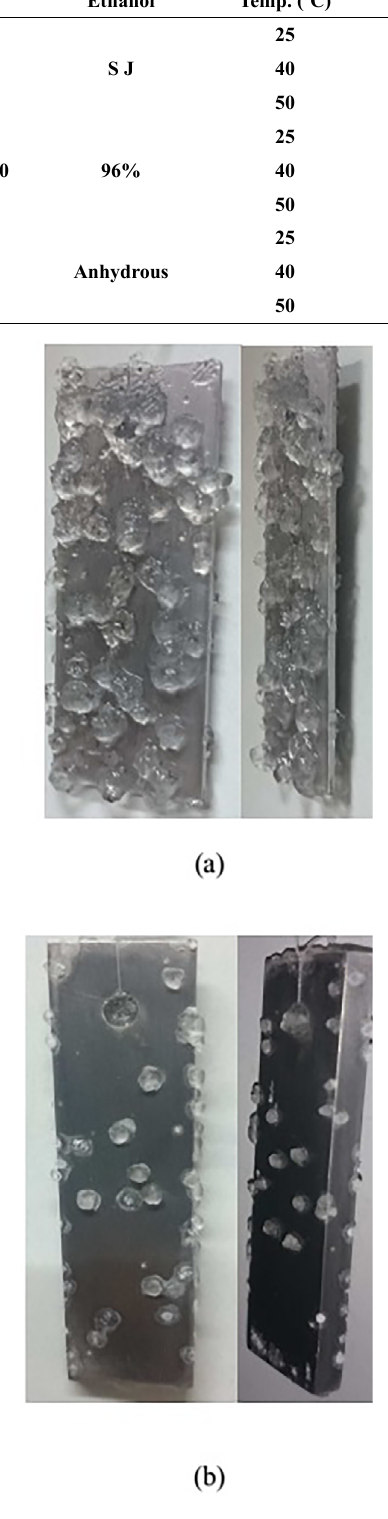
Figure 5. (a) Commercial aluminum in ethanol SJ a 40°C after 16 days of immersion. (b) Al 1050 in SJ ethanol at 50°C after 16 days of immersion.